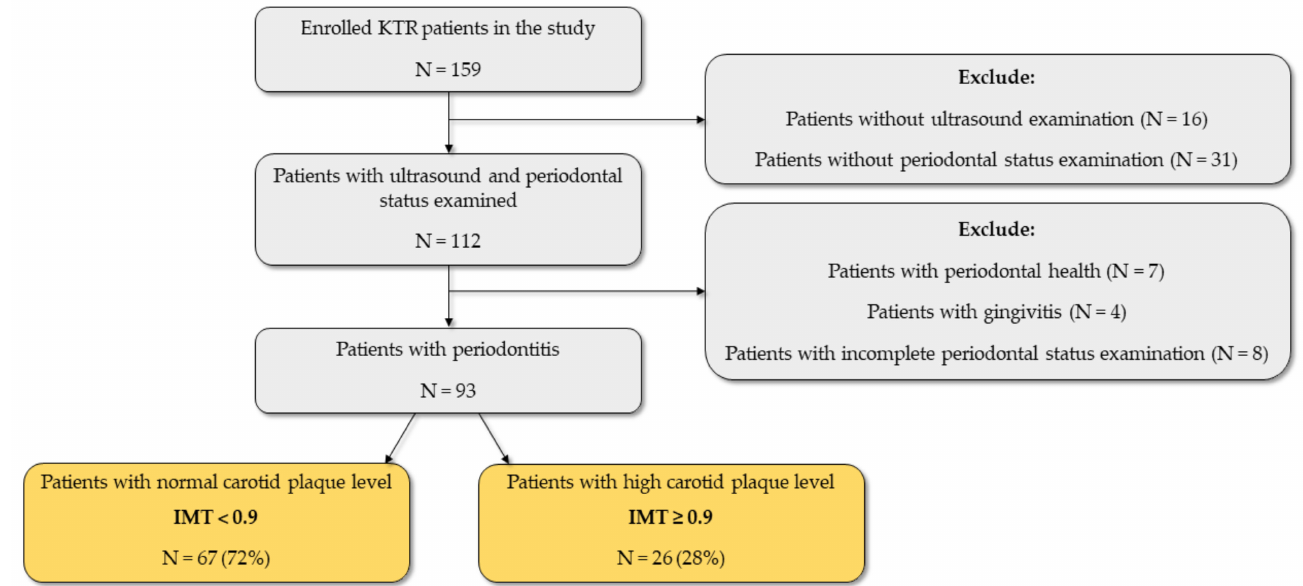
Figure 1. Flow diagram of the study. Abbreviations: KTR, kidney transplant recipient; IMT, intima- media